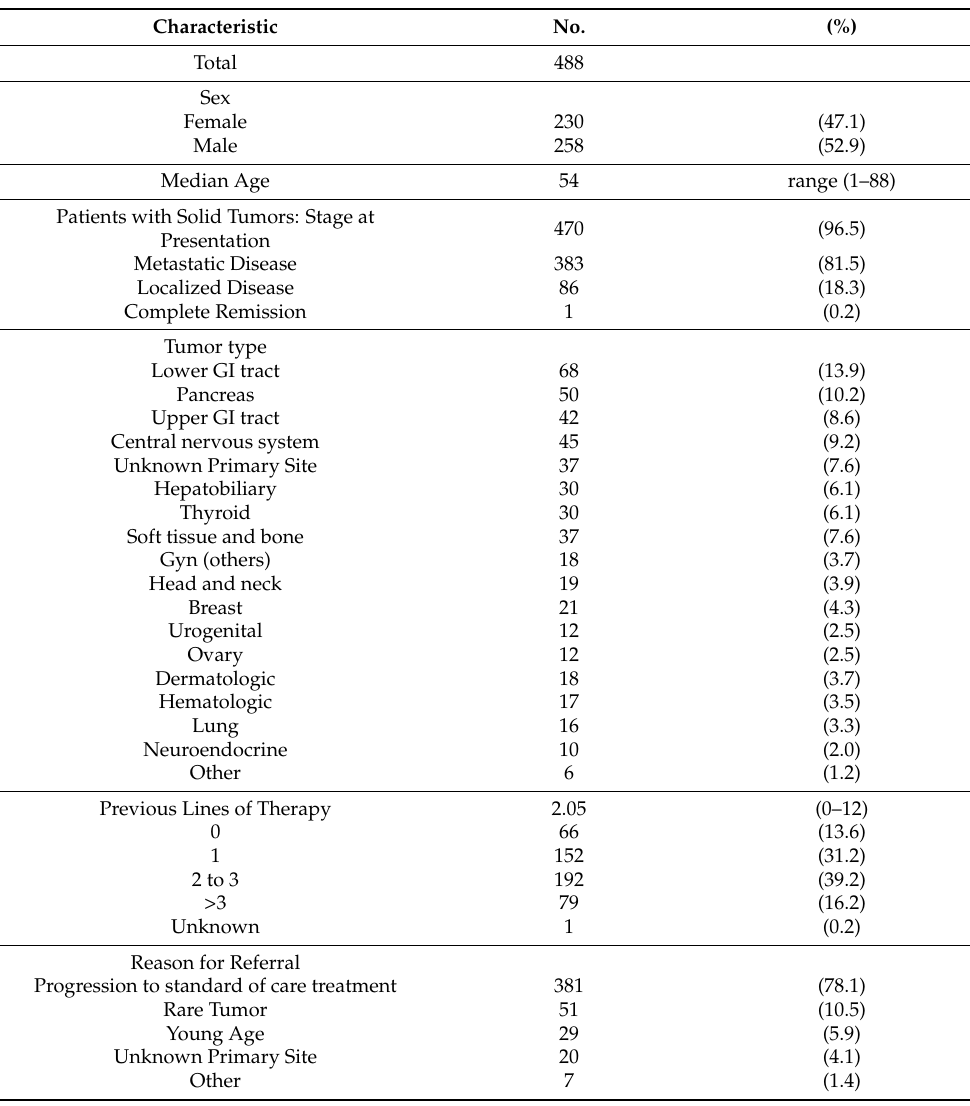
Table 1. Patient